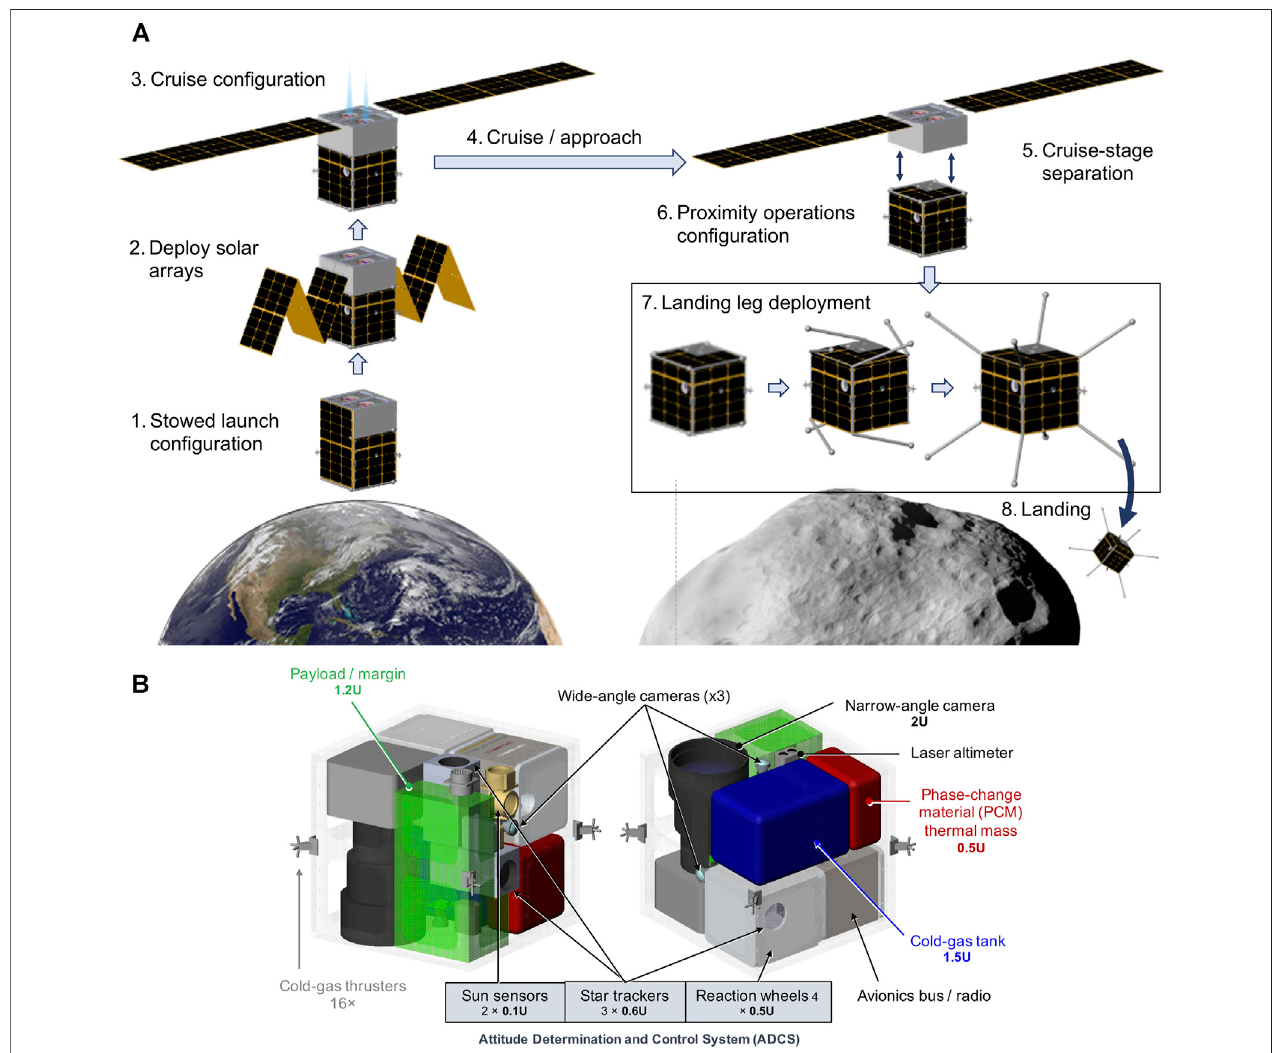
FIGURE 7 | (A) Spacecraft architecture for approach and landing on a small body. (B) Internal con fi guration of notional spacecraft architecture with key components (or volume allocations). The cubic chassis is protected by eight corner-mounted “ legs ” for landing on any side.